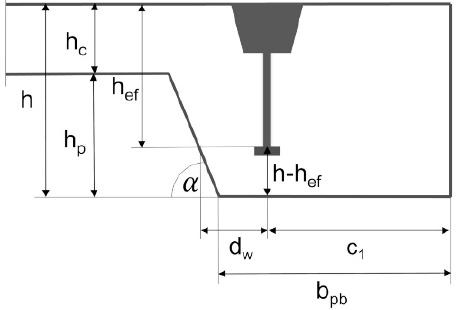
Figure 6. Parameters of the numerical model.